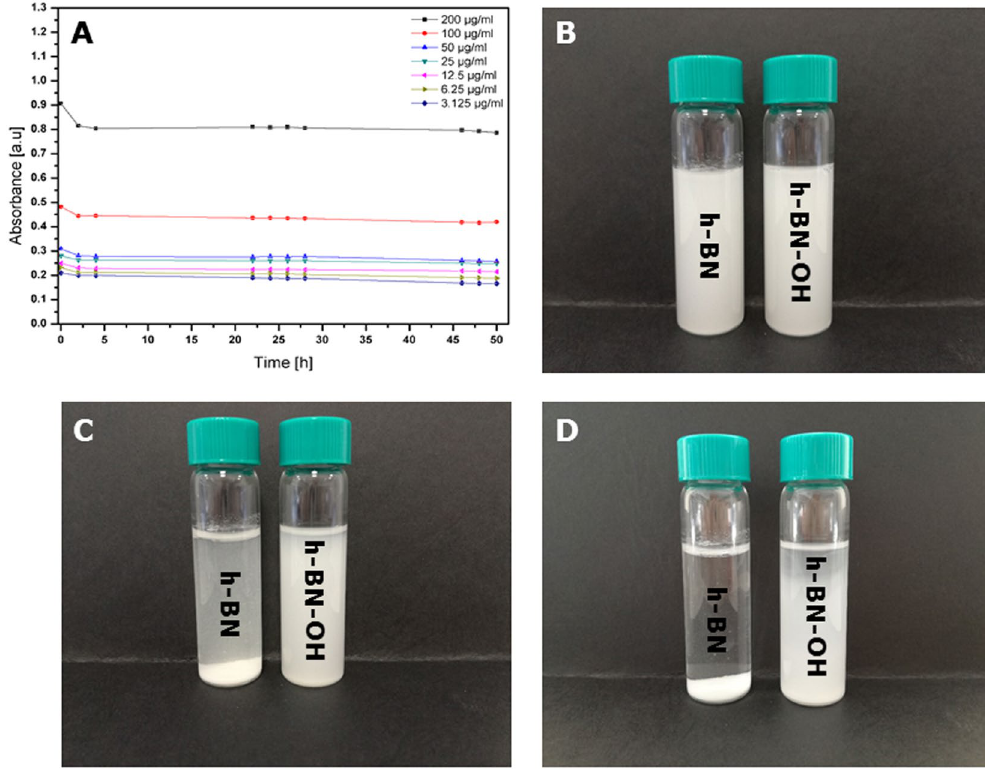
Figure 2. Dispersion stability of h-BN-OH in PBS within the nanomaterial concentration range of 3.125–200 µ g/ml ( A ) and photographs of h-BN and h-BN-OH dispersions in PBS with 200 µ g/ml nanomaterial after 1 hour of sonication ( B ) and after 24 h ( C ) and 48 hours ( D ) of incubation.